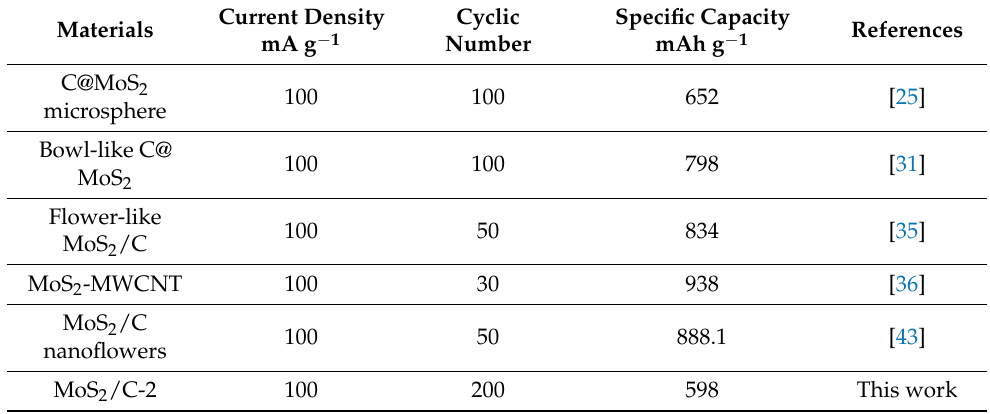
Figure 7. ( a ) Cycling performance of the bulk MoS 2 and MoS 2 /C electrodes measured in the voltage range of 0.01–3.0 V at a current density of 100 mA g − 1 ; ( b ) rate capability of the bulk MoS 2 and MoS 2 /C electrodes between 0.01 and 3 V at different current densities. Table 1. Summary of electrochemistry properties of MoS 2 /C flexible